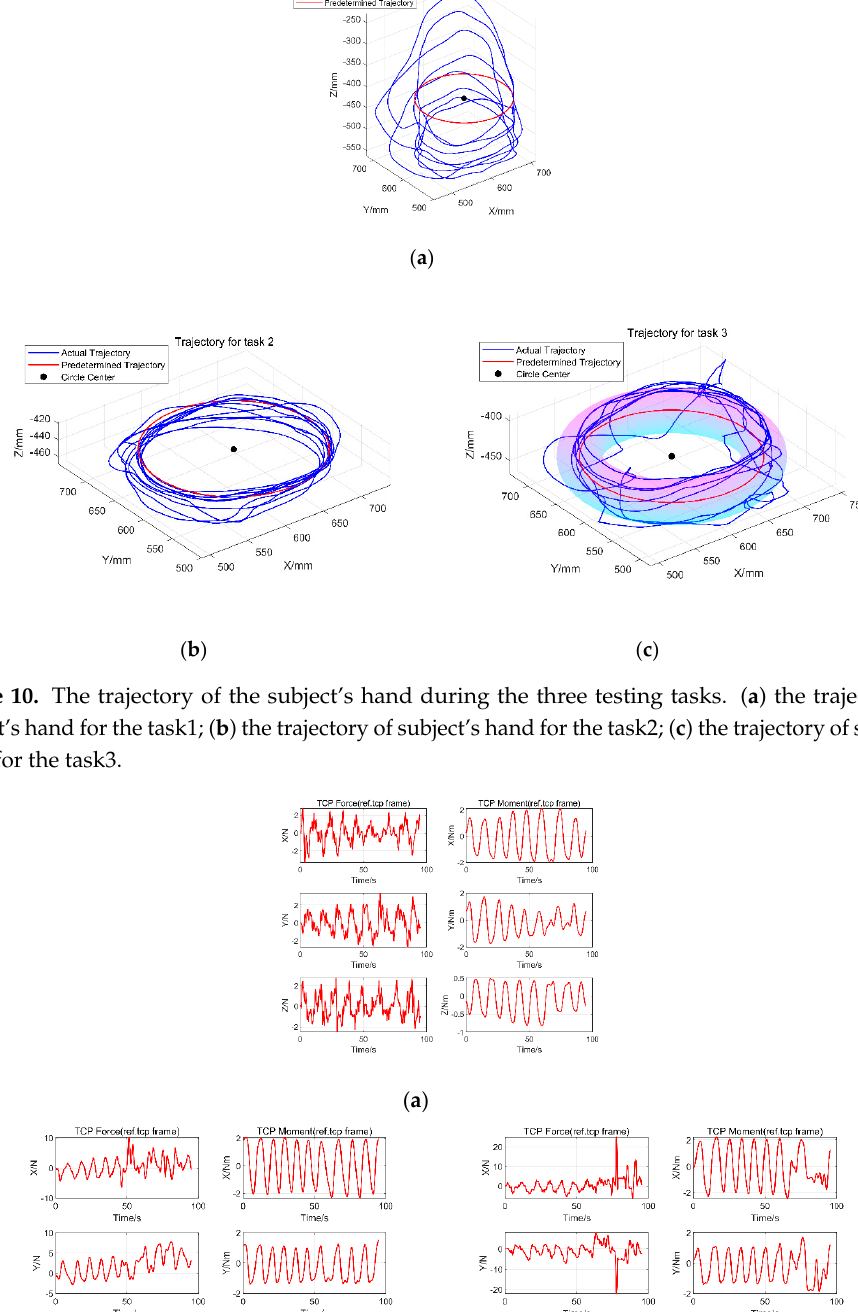
( c ) Figure 12. The position deviation between the subject’s hand and the desired trajectory, and the total interaction force between the participant’s hand and the robot’s handle during the three testing tasks. ( a ) the position deviation and the total interaction force for the task 1; ( b ) the position deviation and the total interaction force for the task 2; ( c ) the position deviation and the total interaction force for the task 3.